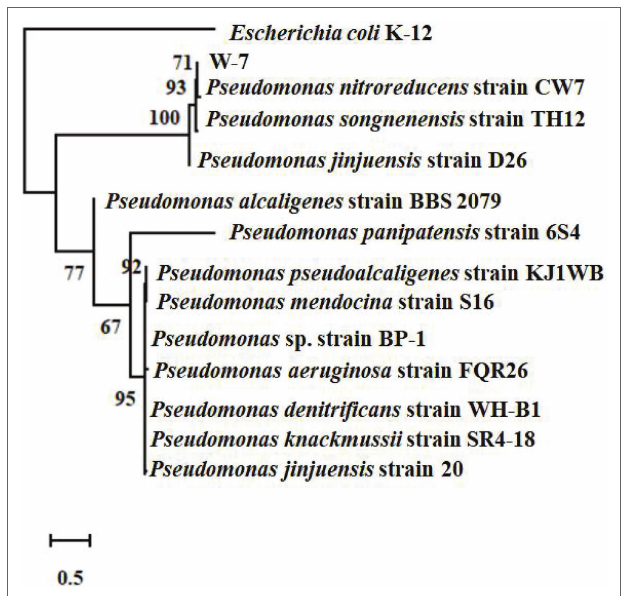
FIGURE 1 | Phylogenetic tree based on the concatenated nucleotide sequences of the 16S rRNA, gyrB , rpoB , and rpoD genes of strain W-7. Consensus sequences of every gene from related bacterial strains were aligned with ClustalW and trimmed in the same sizes. All the sequences from the same strain were assembled to construct a joint neighbor-joining tree. Numbers in parentheses represent GenBank accession numbers. Numbers at the nodes indicate bootstrap values. Bar represents sequence divergence.